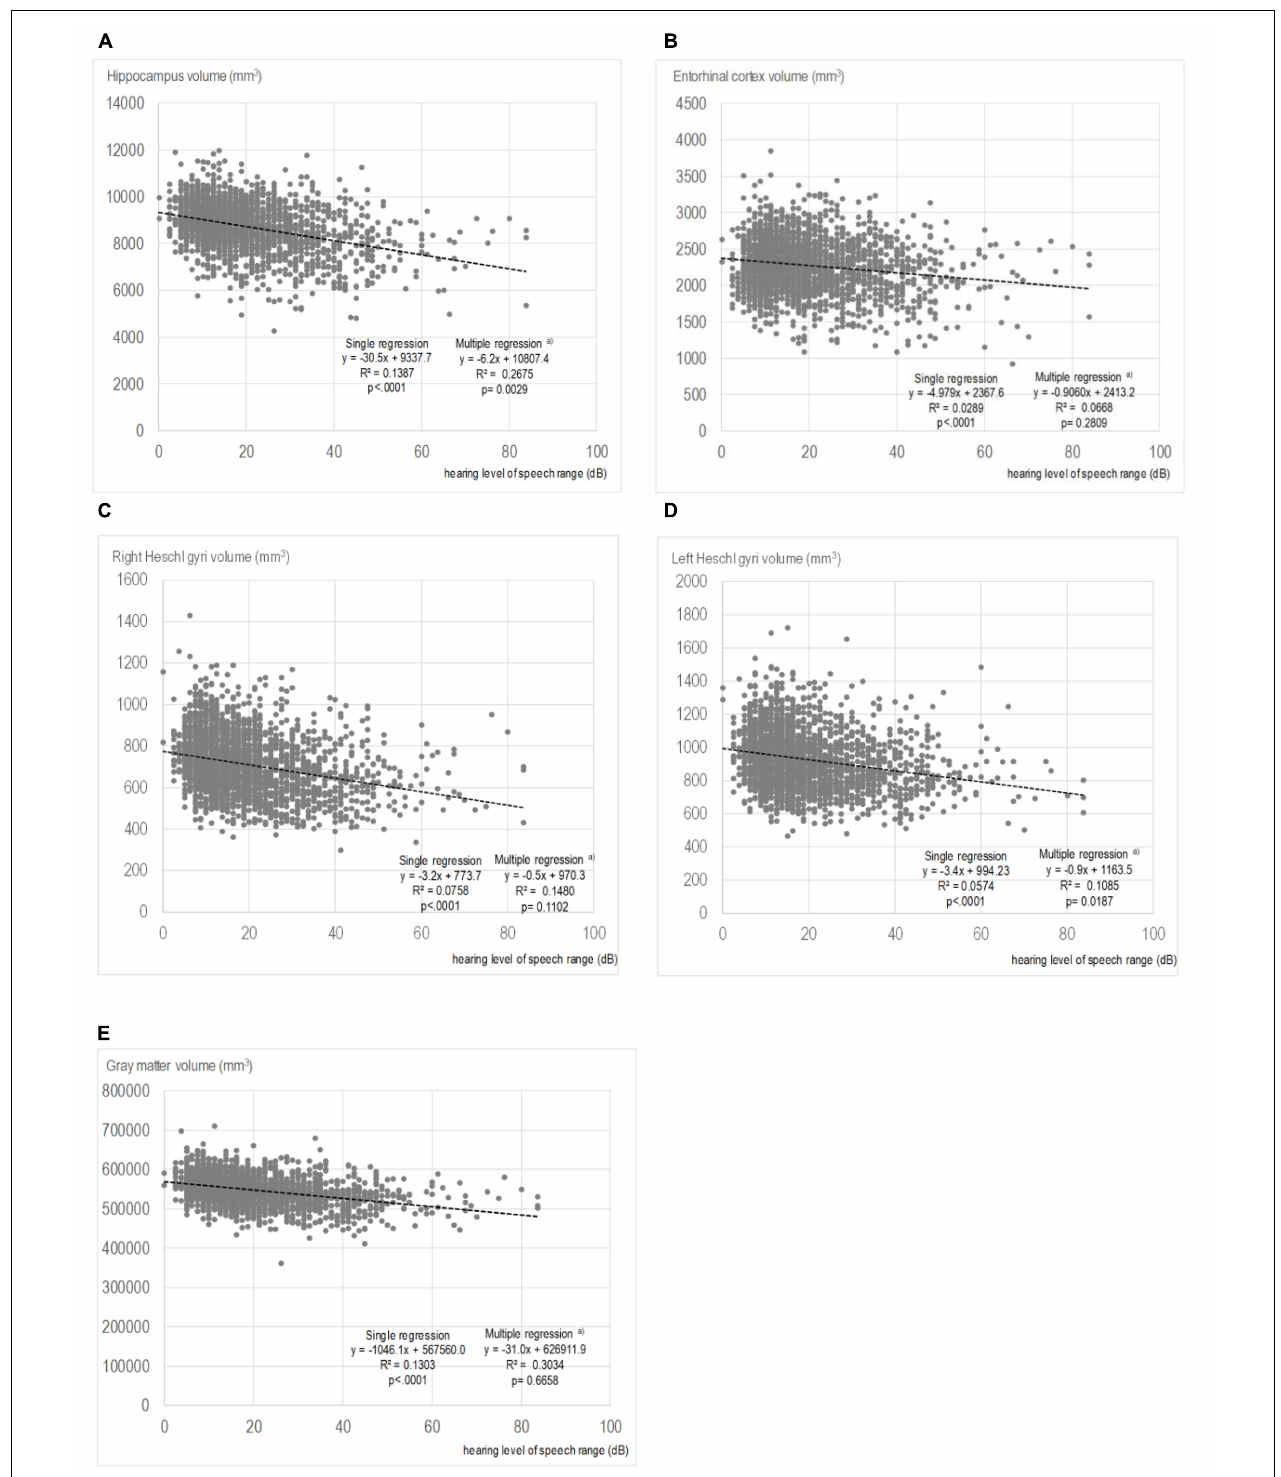
FIGURE 2 | Scatter plots showing the relationships between the volumes of each region and pure-tone average speech. (A) Hippocampus volume and PTA speech. (B) Entorhinal cortex volume and PTA speech. (C) Right Heschl’s gyrus volume and PTA speech. (D) Left Heschl’s gyrus volume and PTA speech. (E) Gray matter volume and PTA speech. In the multiple regressions, adjustments were made for age; sex; smoking status; alcohol consumption; years of education; medical history of hypertension, hyperlipidemia, cardiac disease, and diabetes; and depressive symptoms